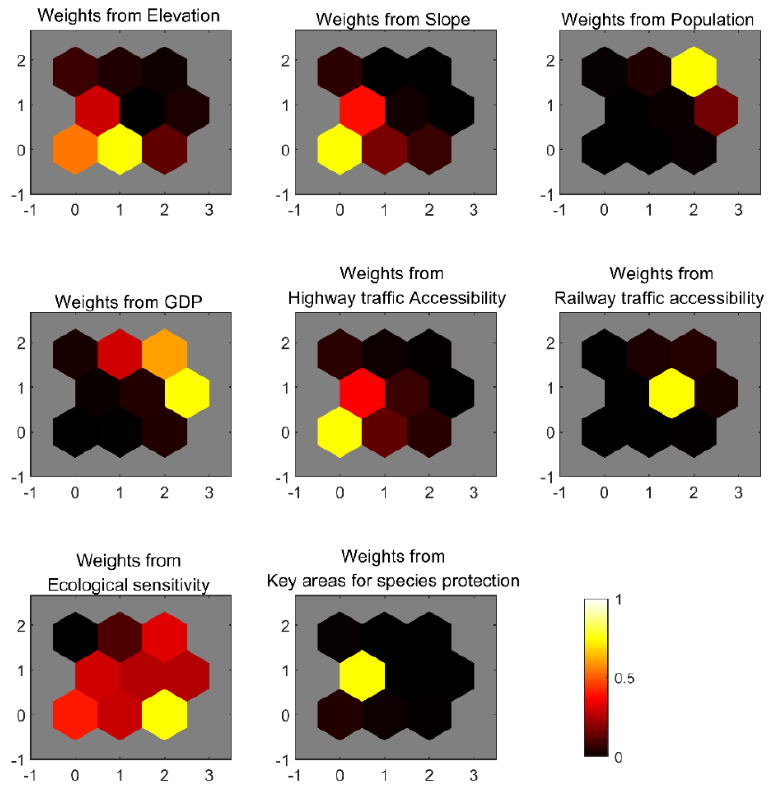
Figure 4. Results of Self-Organizing Mapping Weight Planes. Based on the SOM weight planes, the results of the four types of rural revitalization are shown in Figure 5 in the form of a zoning map, in which the number of each type of village is counted in Table 2. Overall, most of the villages in the country belong to the Out-migration and Relocation category, accounting for 67.0% of all townships or 71.2% of all villages. These villages are generally located in geographically remote or inaccessible areas and lack any noteworthy industrial or other factor endowments. In contrast, the category with the lowest percentage (counted in townships) is the Agglomerative Promo- tion, accounting for 3.9% of all townships or 7.3% of all villages. These villages are mainly located in economically developed areas with dense populations and good transportation locations. Next, the Suburban Annexation category is mainly clustered along major